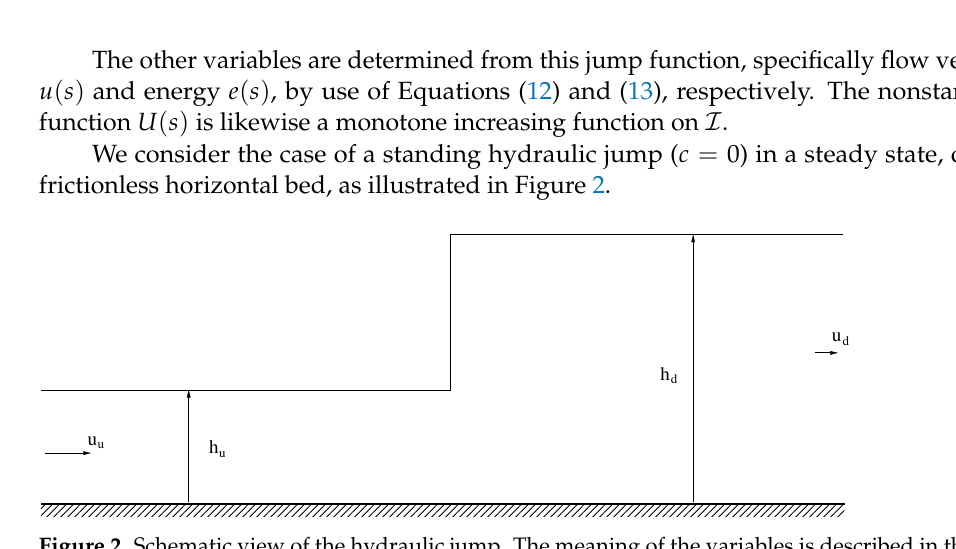
The depth, velocity and energy jump profiles have been computed by setting m = 25 and are presented in Figure 3.